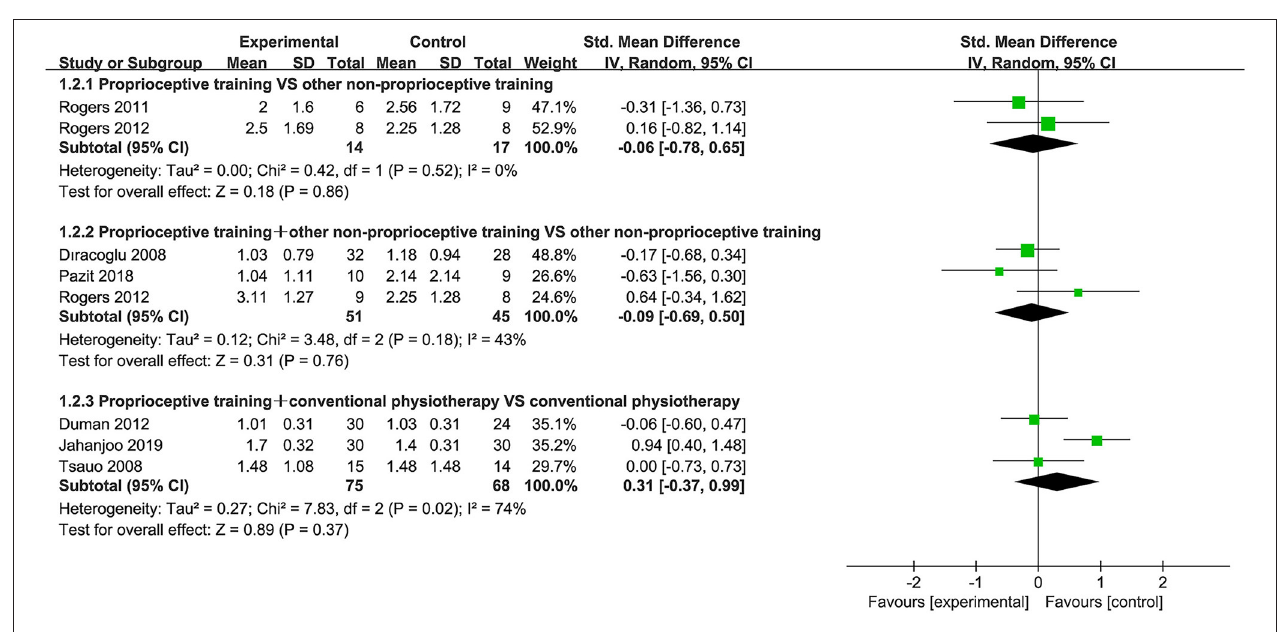
FIGURE 3 | Forest plot of meta-analysis on